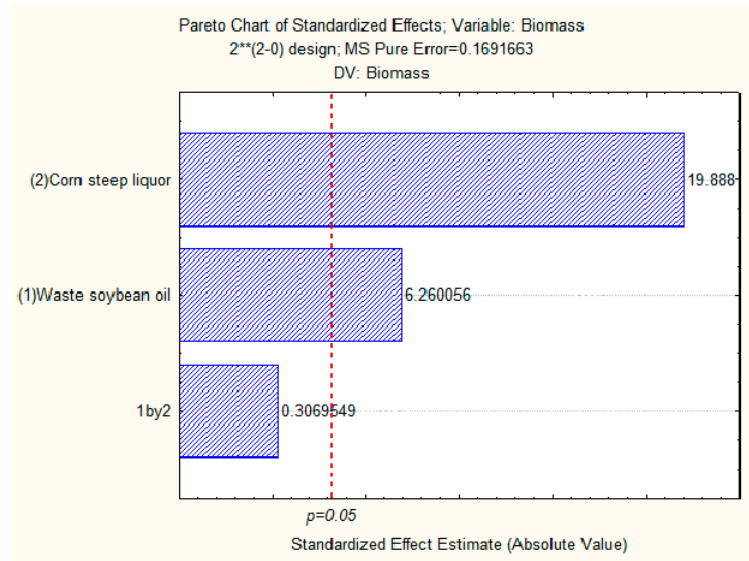
Figure 6 . Pareto chart for 2 2 factorial design of culture of 96 h, where (1) corn steep liquor and (2) waste soybean oil are the independent variables and biomass is the response variable. The point at which the estimates of the effect were statistically significant ( p = 0.05) is indicated by the dotted red vertical line.